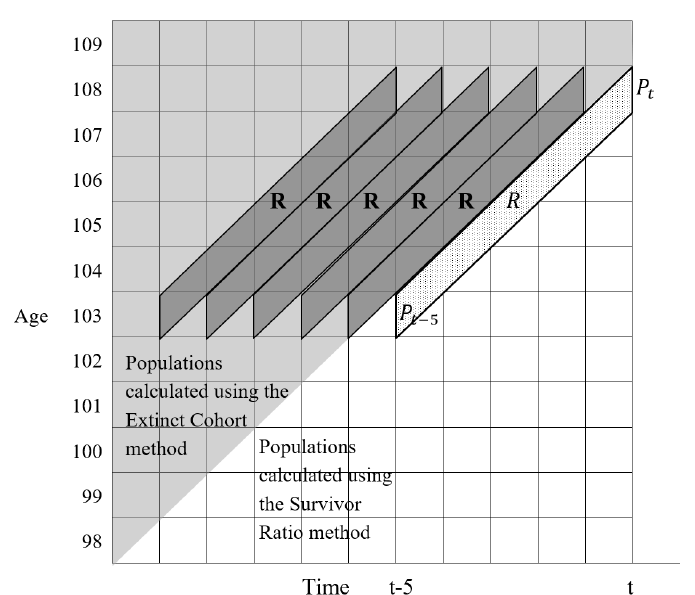
Figure 1: Illustration of a Survivor